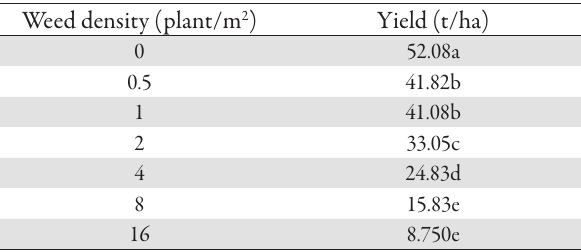
Tab. 2. Sugar beet yield affected by different density of ground cherry weed Weed density (plant/m 2 )